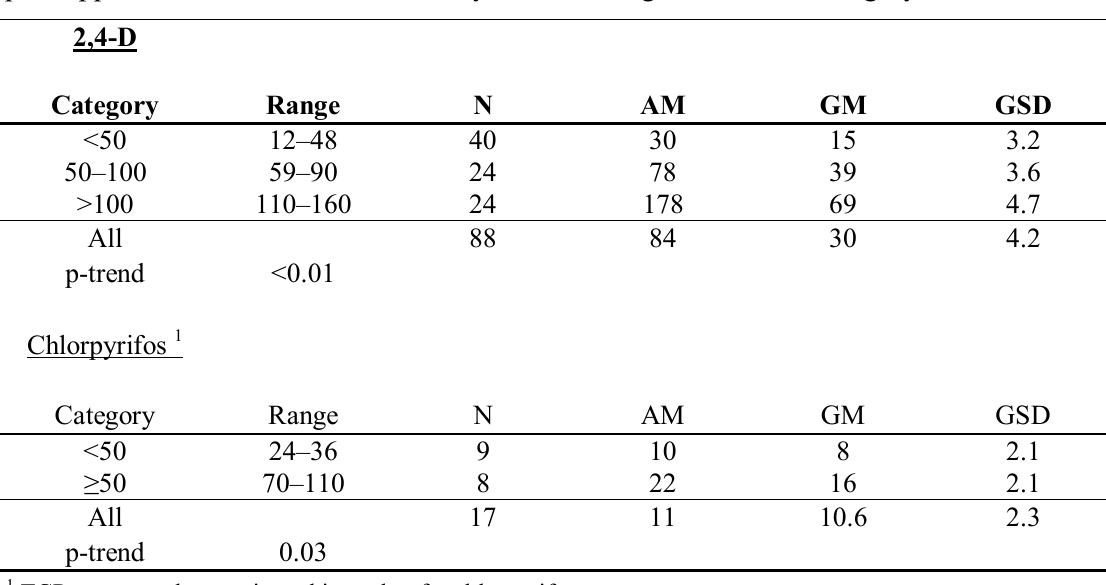
Table 5. Arithmetic means, geometric means and geometric standard deviation of post-application urine concentrations by Version 2 algorithm score